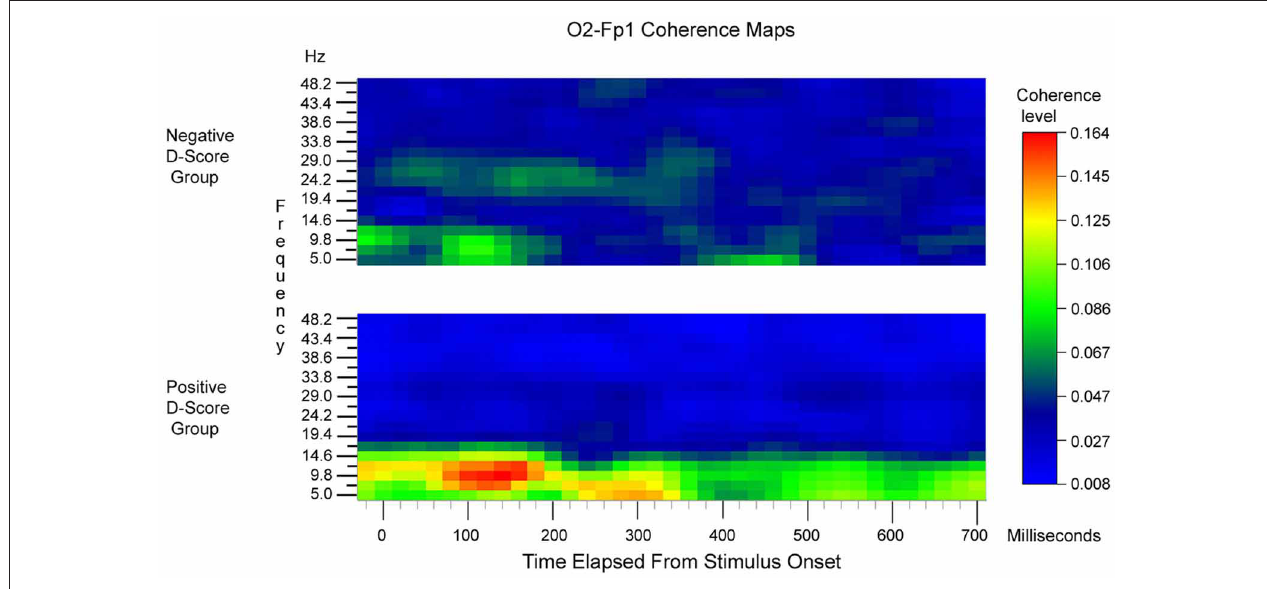
FIGURE 3 | O2-Fp1 Time × Frequency coherence maps, pooled across congruent and incongruent blocks and averaged across subjects. The upper map is the average for subjects with